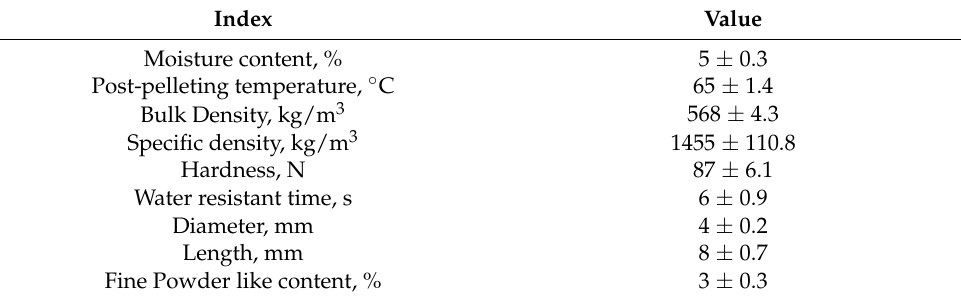
Table 3. The main physical parameters of the